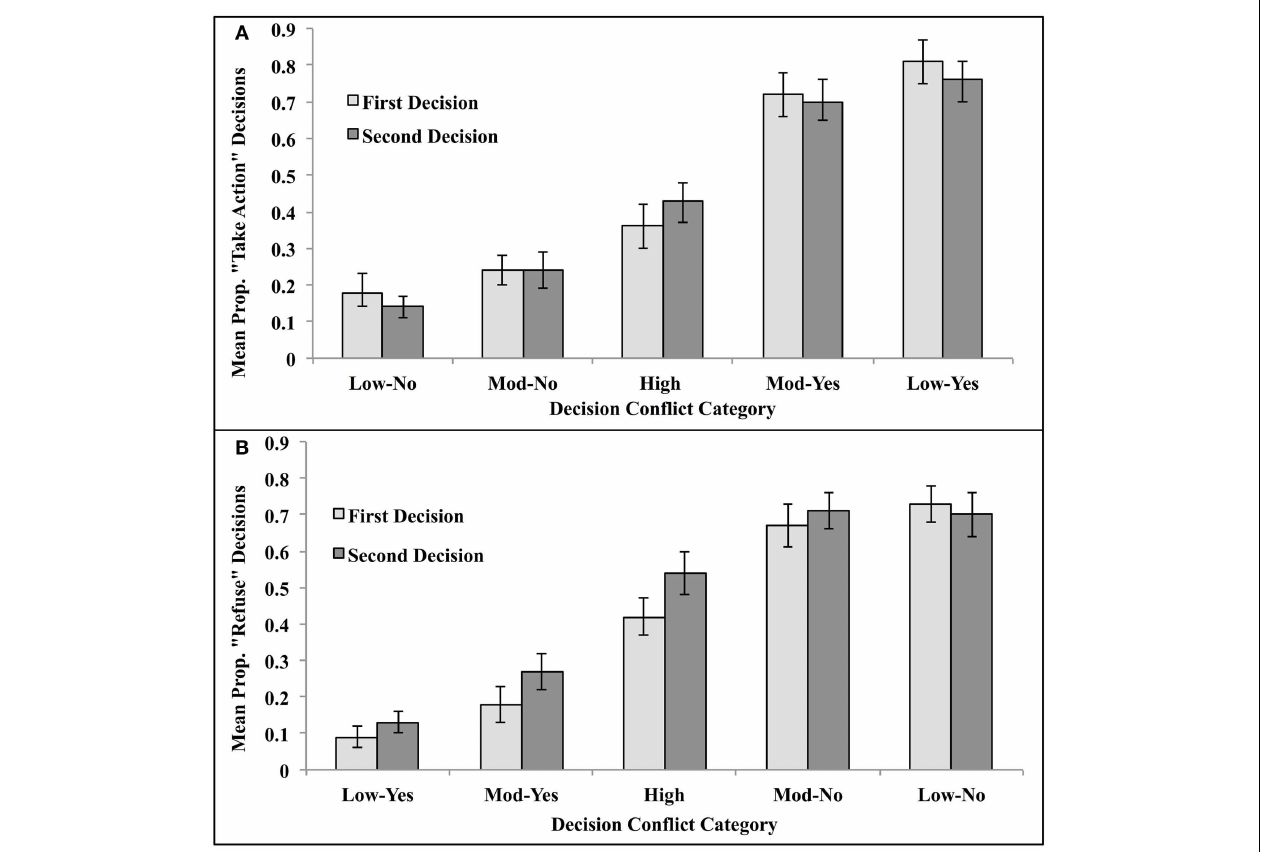
FIGURE 5 | Proportion utilitarian decisions made under unlimited- and reduced-decision time for high decisional conflict vignettes, moderate conflict vignettes, and low-conflict vignettes when the moral judgment was queried as (A) “Is it appropriate to <take the described action>?” or